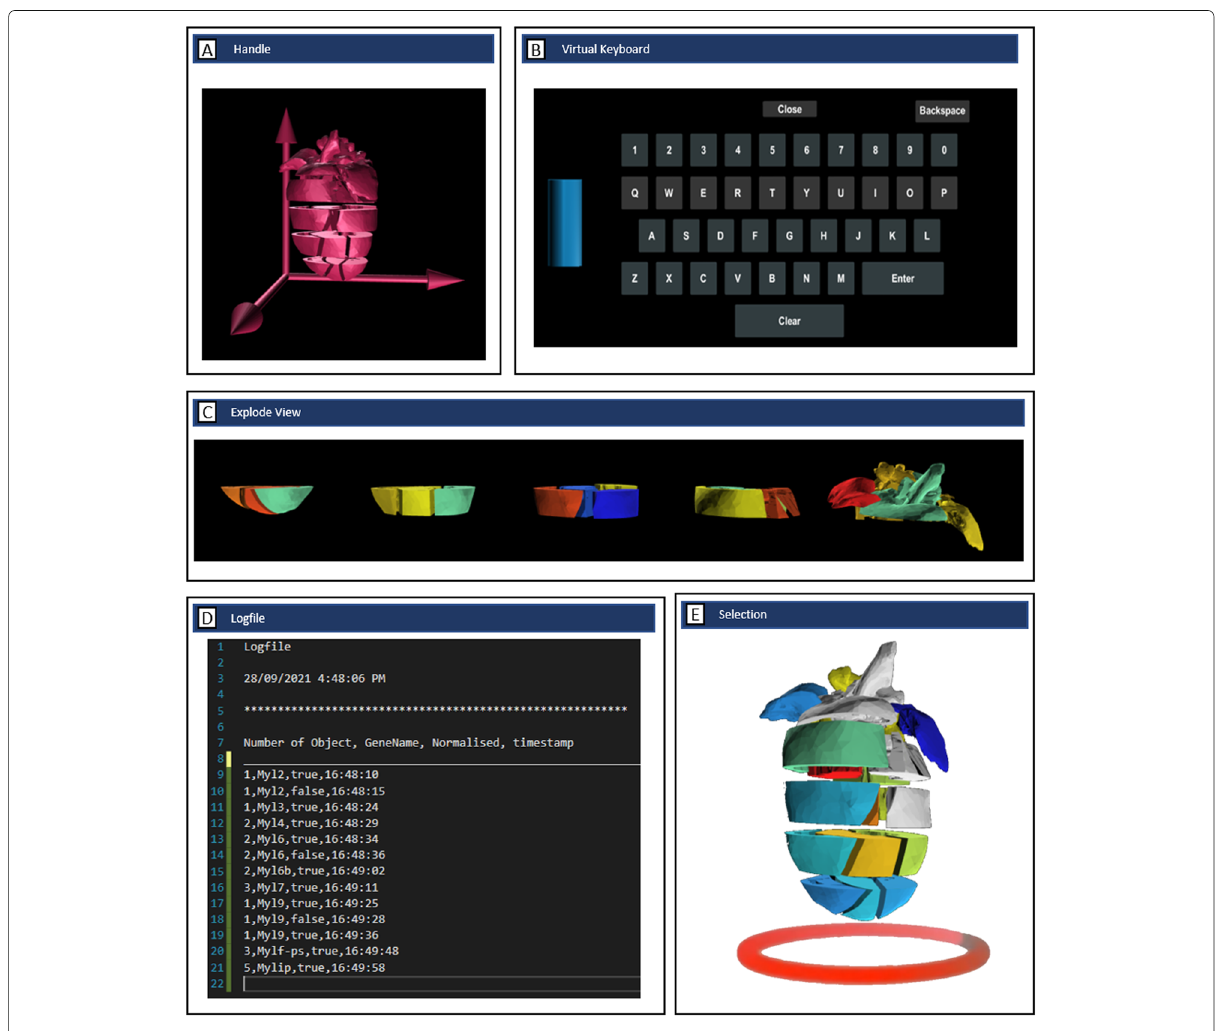
Fig. 2 VR-Cardiomics features. A) Handle for rotating the heart model of the HMD-VR prototype. B) Virtual keyboard with a handle for text input. C) Example of expanded features of the heart model to provide a better overview of the heart slices in both environments. D) Backup file created during runtime to keep track of all selected gene expressions, which model the genes were expressed on, information regarding normal or absolute views, and a timestamp. E) Example selection of heart